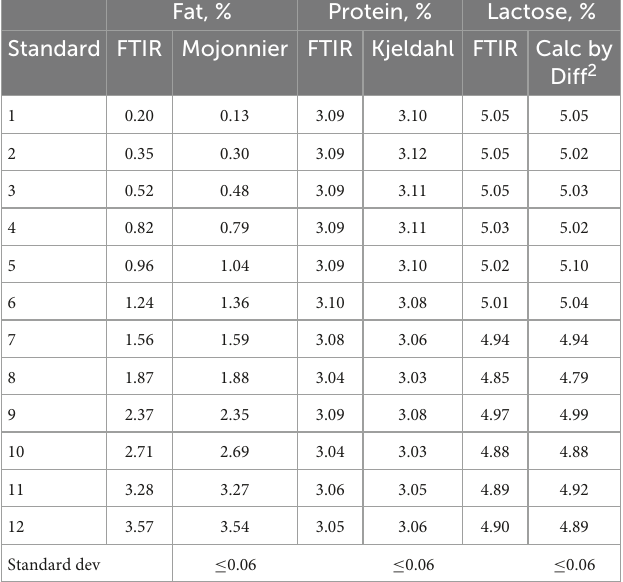
TABLE 2 Separation of lactose and oligosaccharides in mare milk using solid phase extraction (SPE). Lactose, mM Pre-SPE Diff 2